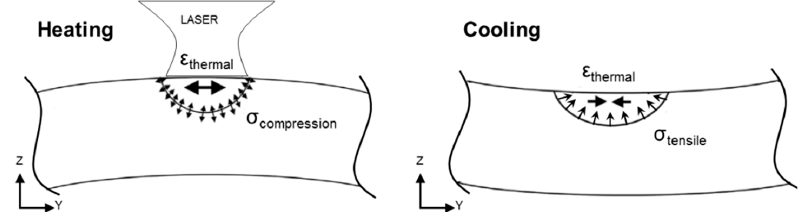
Figure 6. Mechanism of formation of thermal stress and strain induced by the temperature gradient from the laser beam during heating and cooling [23,25].